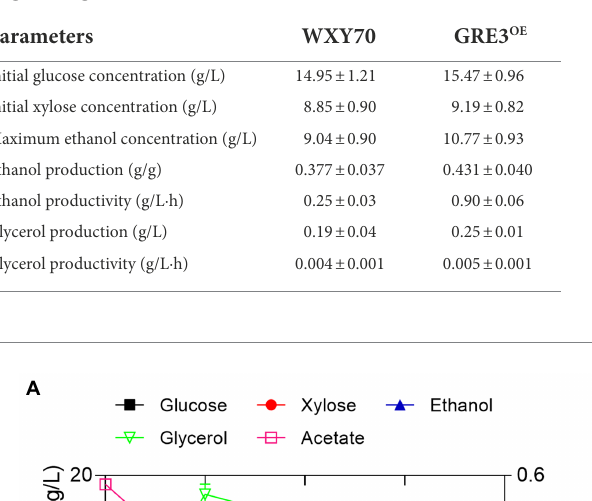
TABLE 2 Comparison of fermentation profile in alkaline-distilled sweet sorghum bagasse fermentation between WXY70 and GRE3 OE of the 48 h.